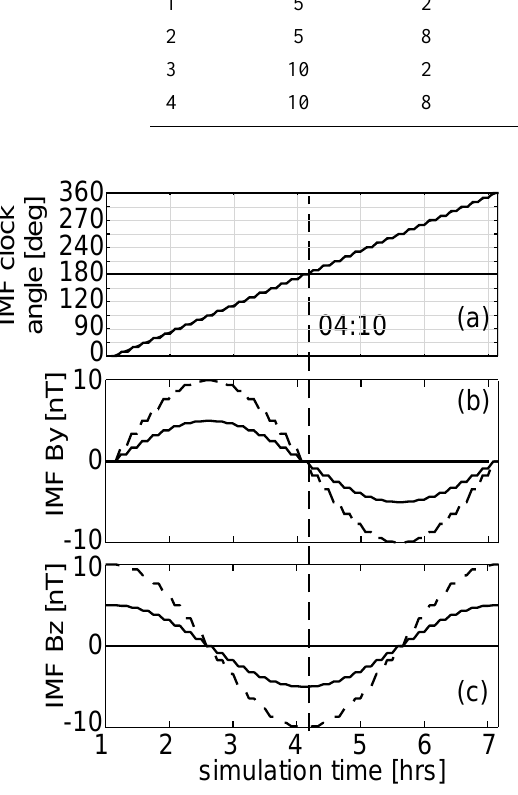
Fig. 1. Time evolution of (a) IMF clock angle, (b) IMF y compo- nent, and (c) IMF z-component for simulation runs; solid (dashed) line is for runs where IMF magnitude is 5 (10)nT. See Table 1 for further details of the run